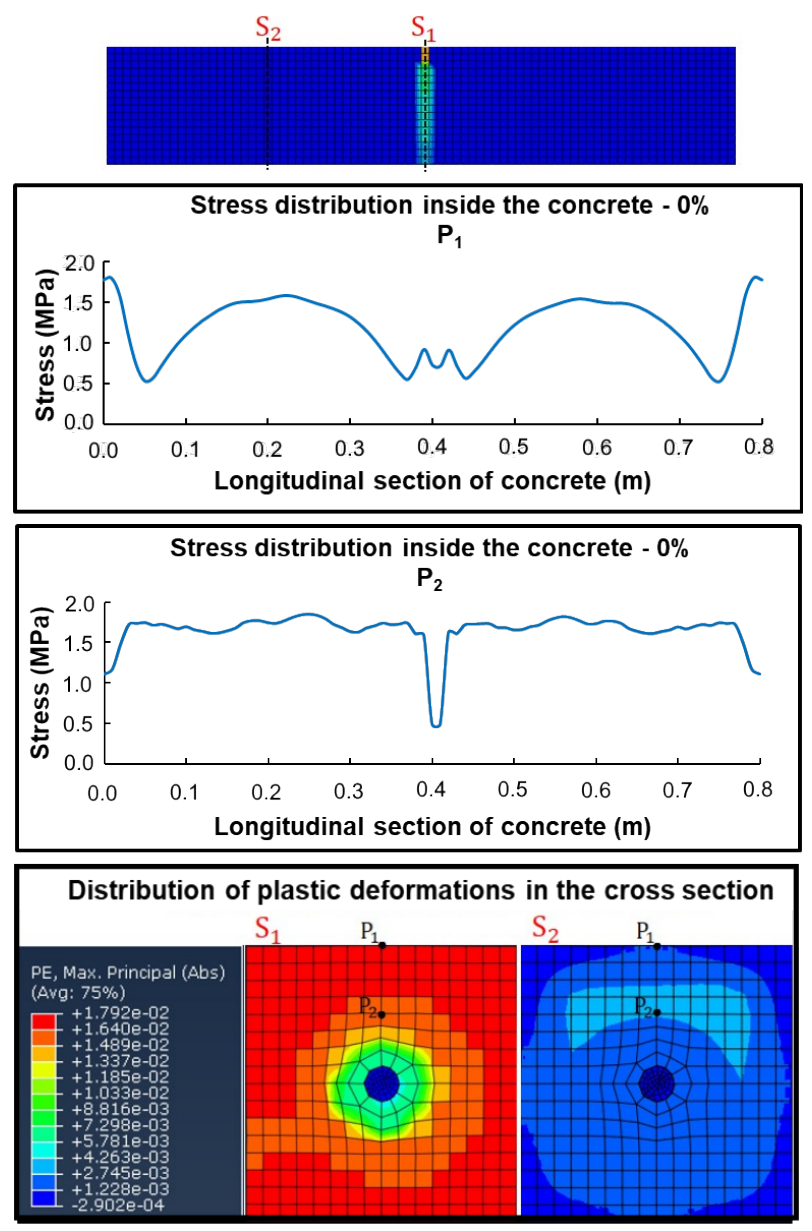
Figure 16. Stress and strain distribution in concrete and in reinforcement for R0